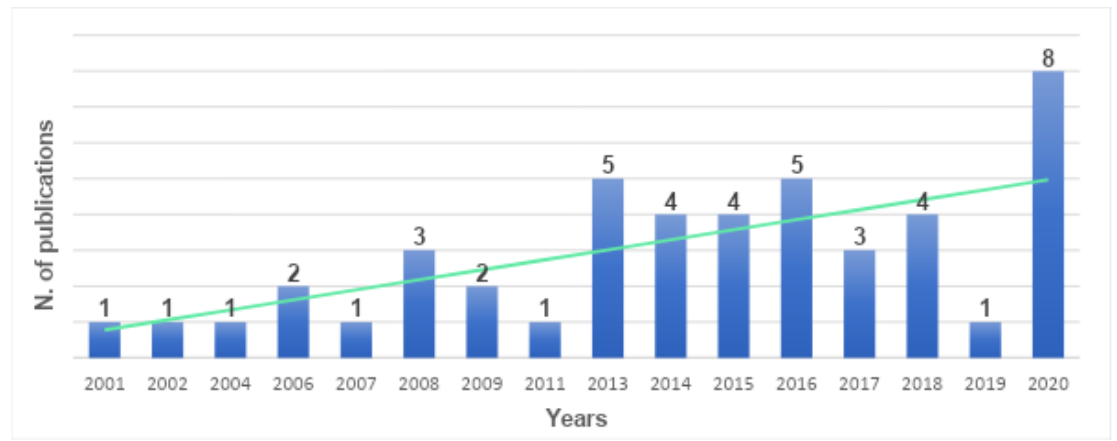
Figure 3. Numbers of articles published per year (source: own elaboration).